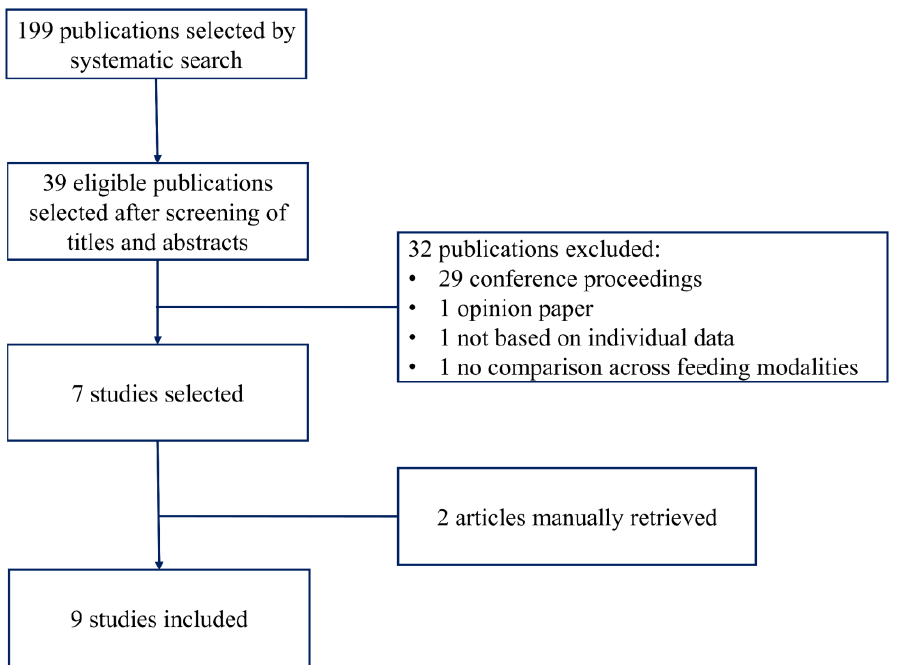
Figure 1. Flow diagram of the studies selection. Table 1. Summary overview of the selected